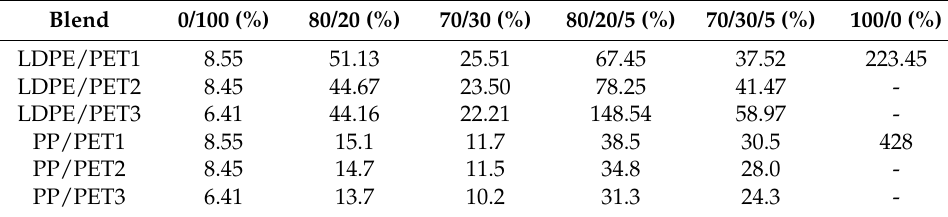
Table 5. The elongation at break of polymer blends.